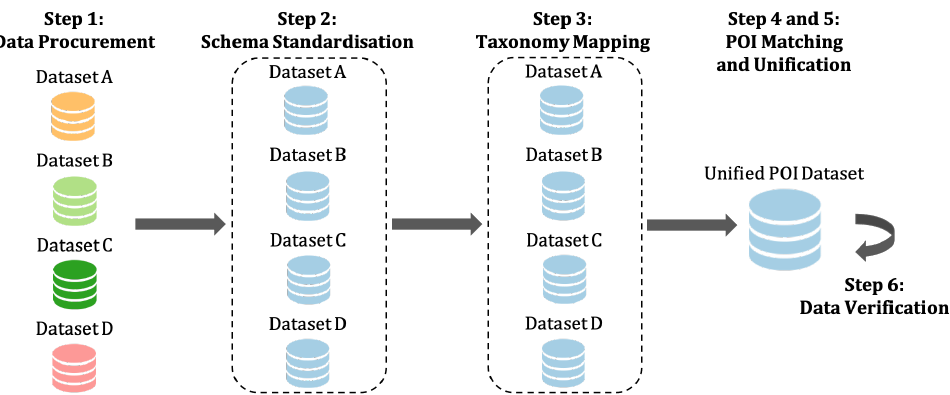
Figure 1. Overview of the proposed POI conflation